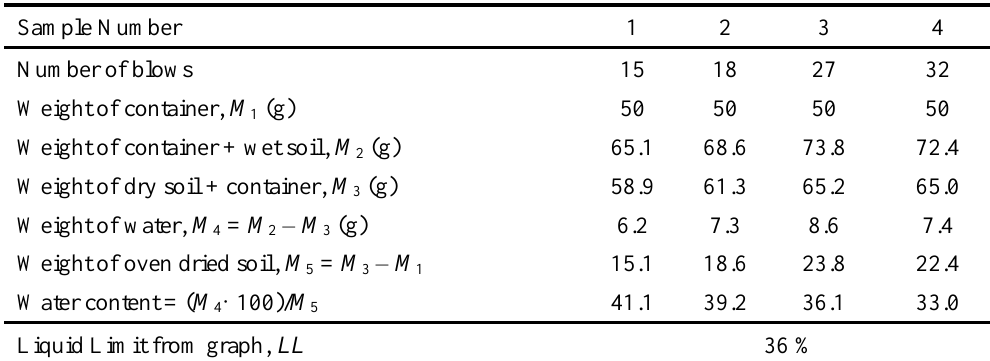
Table 3. Liquid Limit of Laterite Soil (developed by the authors, based on the conducted